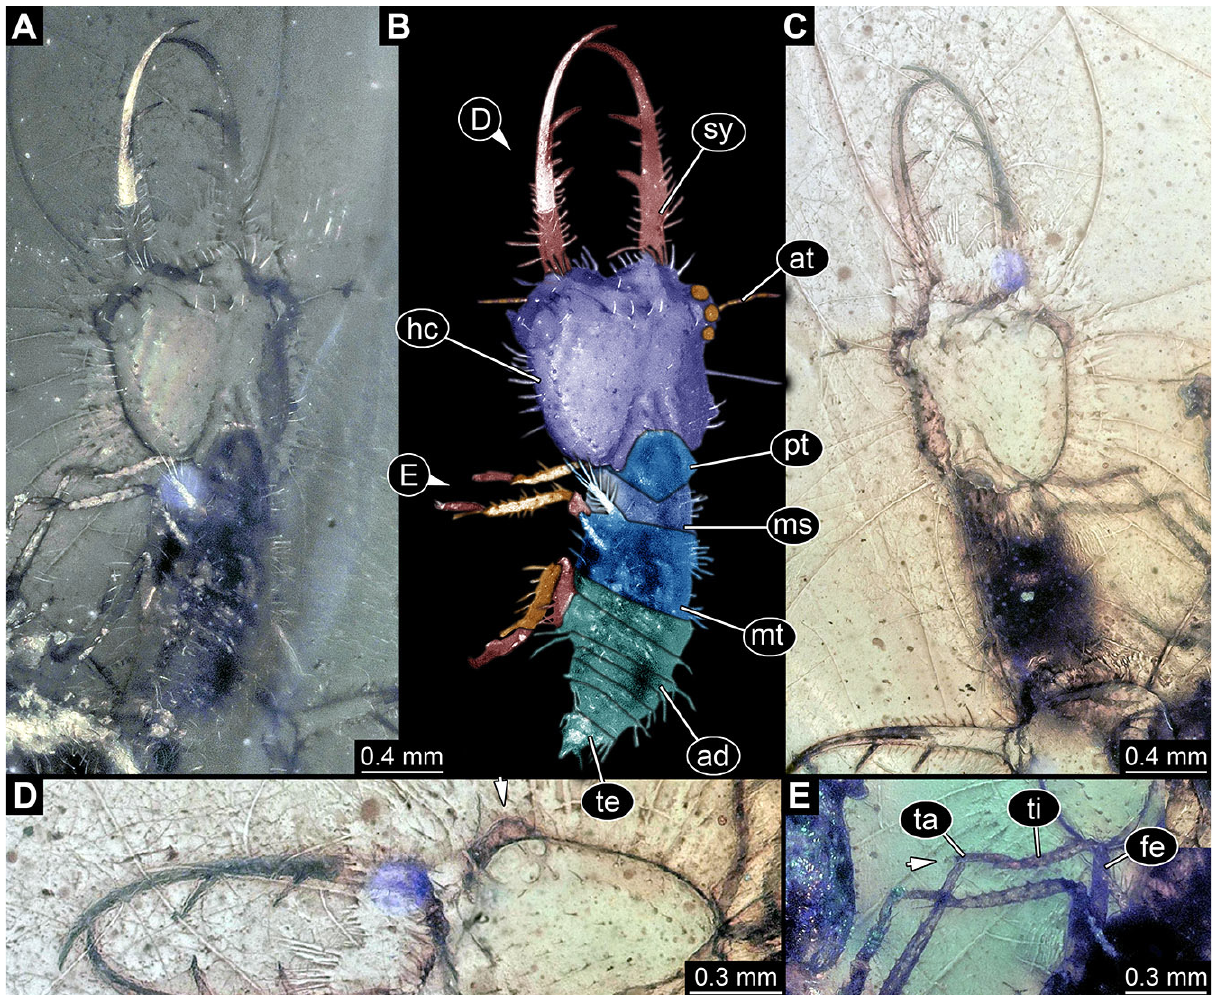
Figure 17. Fossil owllion larva, specimen 3230 (PED 0083d), Cretaceous Kachin amber, Myanmar. ( A ) Overview, dorsal. ( B ) Color-marked version of ( A ). ( C ) Overview, ventral. ( D ) Close-up on head capsule with field of stemmata (arrow). ( E ) Close-up on locomotory appendage with claws (arrow). Abbreviations: ad = abdomen; at = antenna; fe = femur; hc = head capsule; ms = mesotho- rax; mt = metathorax; pt = prothorax; sy = stylet; ta = tarsus; te = trunk end; ti = tibia.